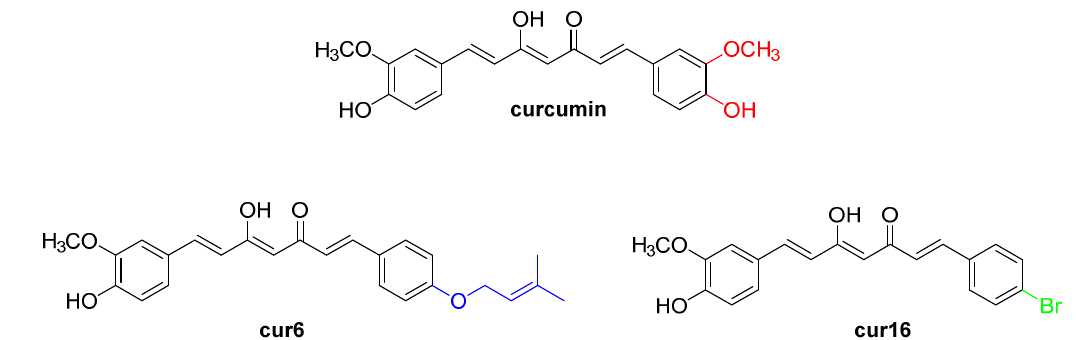
Figure 1. Chemical structures of curcumin and its analogues cur6 and cur16 .